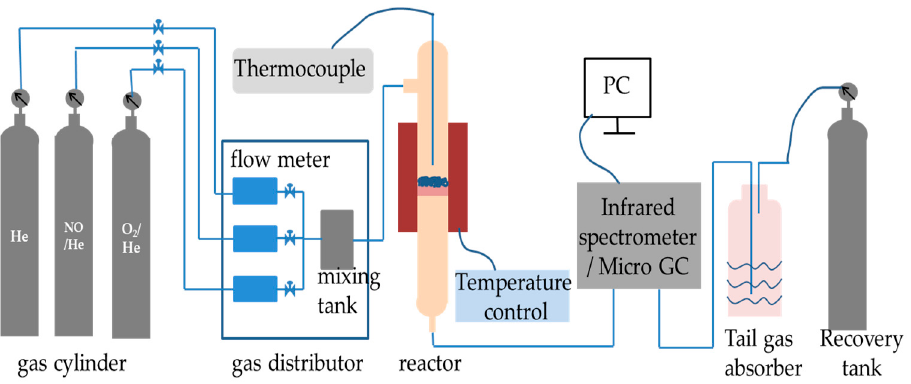
Figure 1. The experimental setup for decomposition of NO.